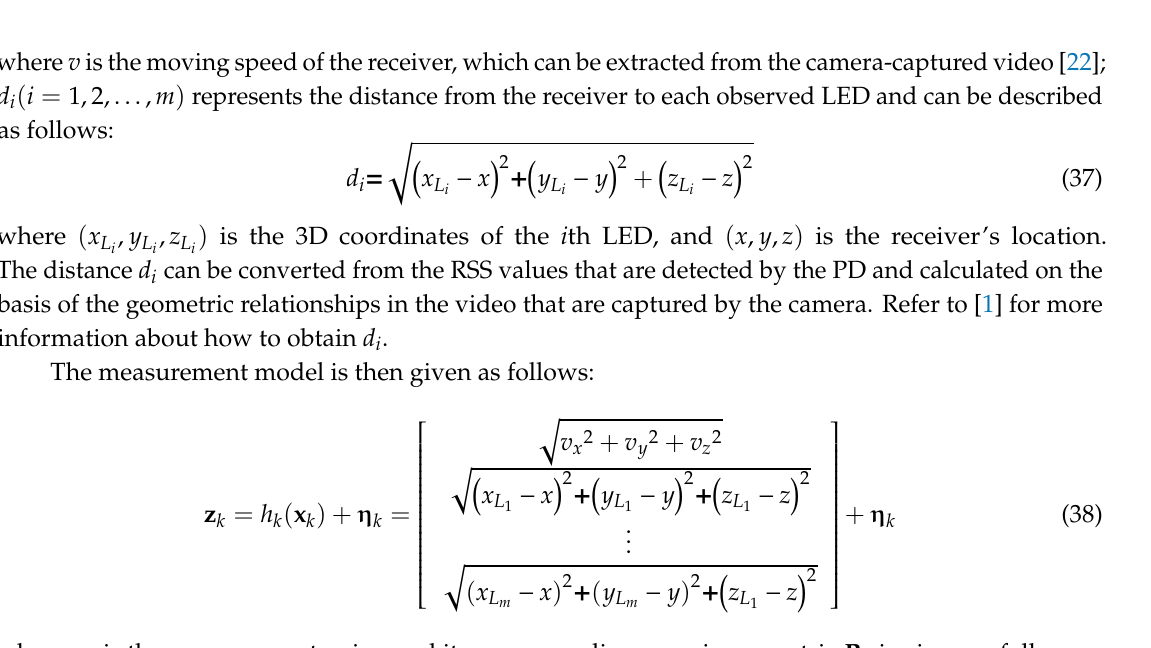
( b ) Figure. 3. The mobile robot and receiver module: ( a ) Mobile robot and ( b ) Receiver module installed on the mobile robot. Table 1. Receiver Parameters. PD: photodiode, FOV: field of view Receiver Parameters Quantity PD type FOV of PD PD area Camera type FOV of camera Image pixel size Image resolution